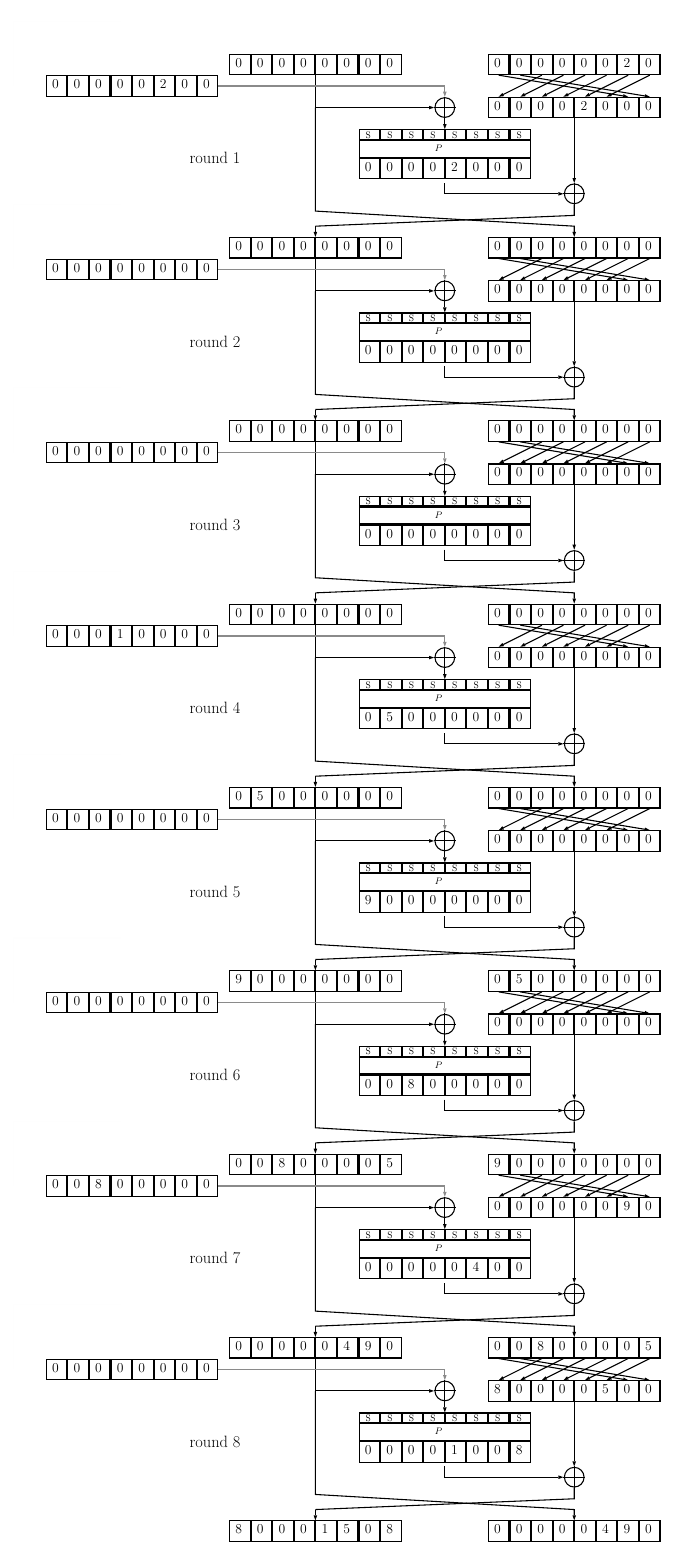
Figure 9: The 8-round related key characteristic used in Liu et al.’s attack, used for both E 0 and E 1 with ∆ K 1 = ∆ K 9 , ∆ K 2 = ∆ K 10 , · · · , ∆ K 8 = ∆ K 16